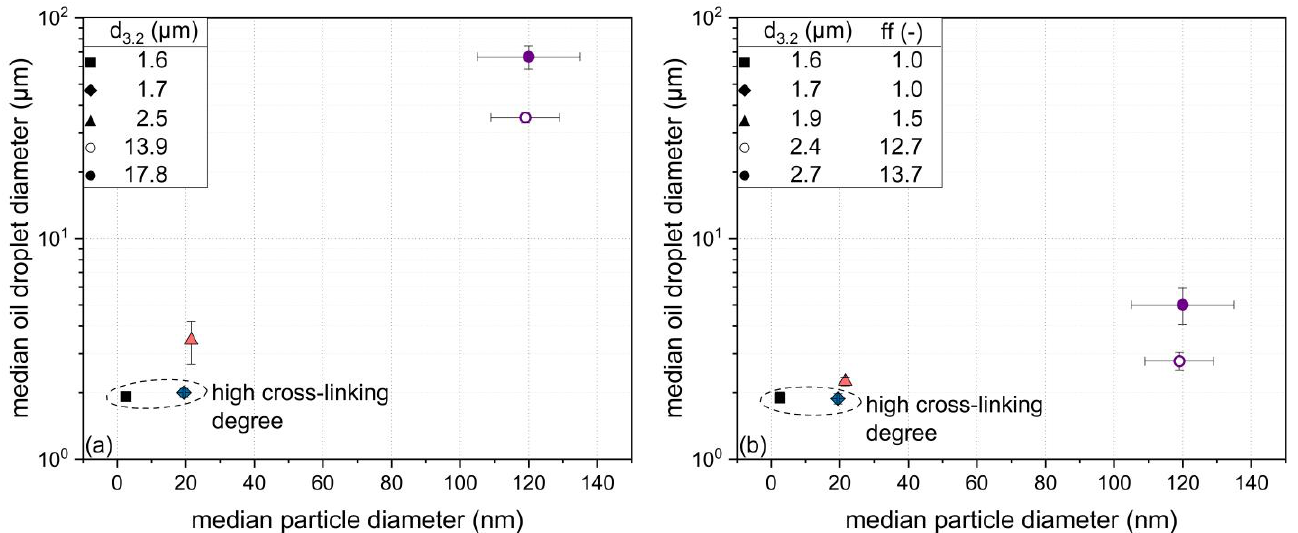
Figure 6. Median oil droplet diameter (and surface weighted mean (d 3.2 )) in dependence of the median particle diameter ( a ) without the addition of sodium dodecyl sulfate (SDS) and ( b ) with the addition of SDS and including the flocculation factor ( ff ) using a particle concentration of 8.2 g L − 1 (degree of disulfide cross-linking/zeta potential: ▲ 92%/ − 29 mV, ○ 104%/ − 30 mV, ● 104%/ − 38 mV, ◆ 109%/ − 31 mV, and ■ 120%/ − 30 mV). Error bars indicate standard deviation.